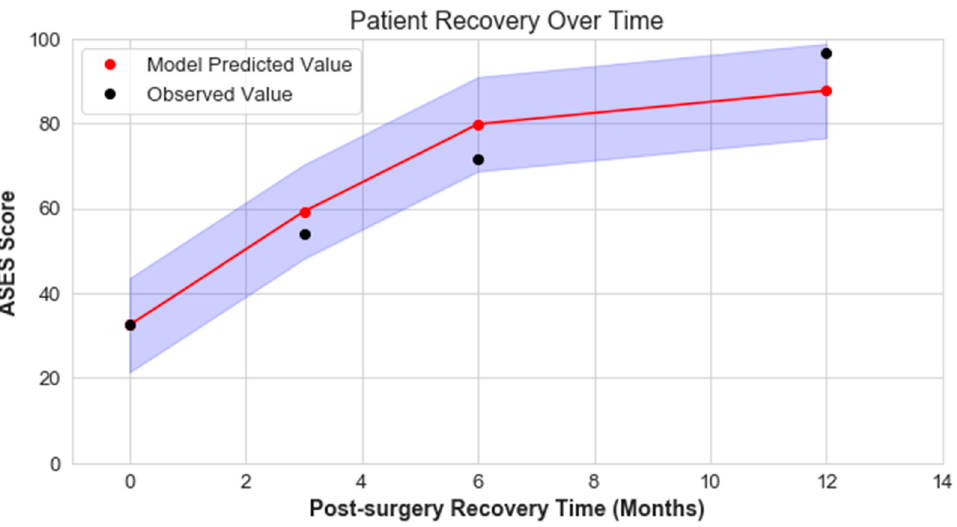
Figure 5. Model predicted 3-, 6-, and 12-month post-operative ASES scores (red) based on pre-operative information for a patient from the test dataset. The observed ASES score (black) is also shown. The shaded region (blue) indicates the bounded area for the MCID value of 11.1.